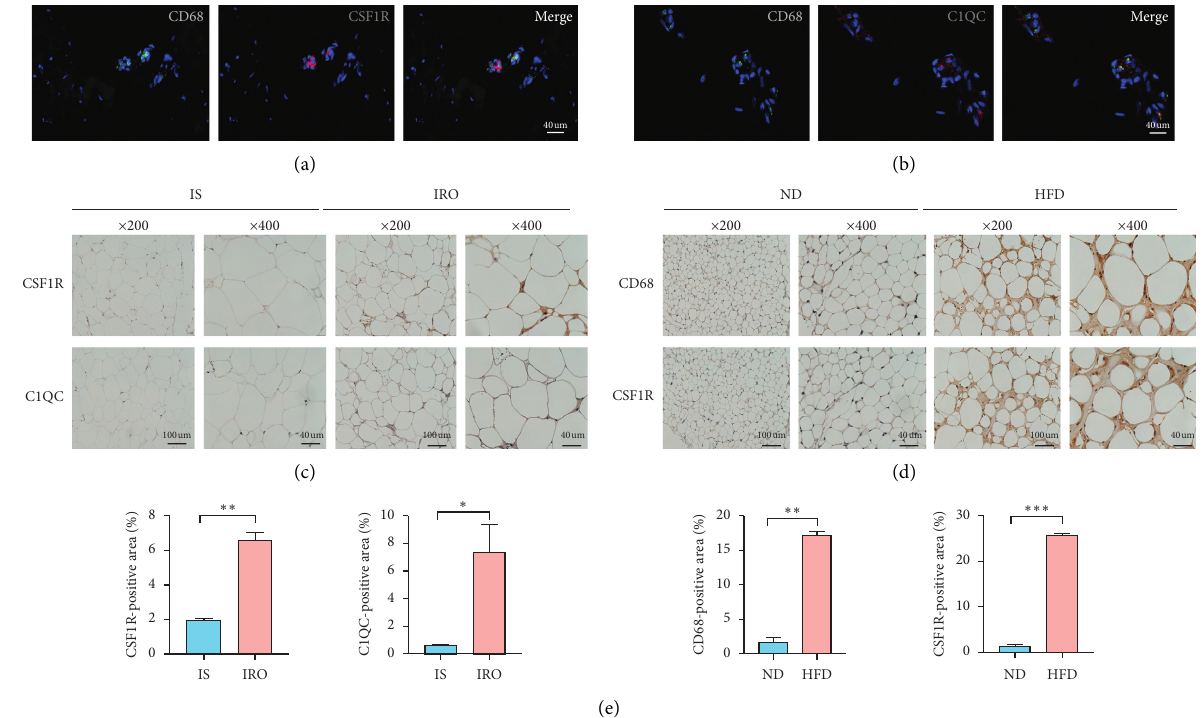
Figure 8: Hub genes’ expression was related to macrophage’s proinflammation in adipose tissue. (a) Immunofluorescence staining for CD68 and CSF1R in the VATtissue from IRO patients. Scale bar � 40um. (b) Immunofluorescence staining for CD68 and C1QC in the VATtissue from IRO patients. Scale bar � 40um. (c) Immunohistochemical staining for CSF1R and C1QC in the VAT tissue between IRO patients group and IS group. The scale bar is 100um and 40um, respectively. (d) Immunohistochemical staining for CD68 and CSF1R in the VAT tissue between ND-fed mice group and HFD-fed mice group. (e) Quantitative analysis of IHC results of hub genes. ∗ P value < 0.05. ∗∗ P value < 0.01. ∗∗∗ P value <